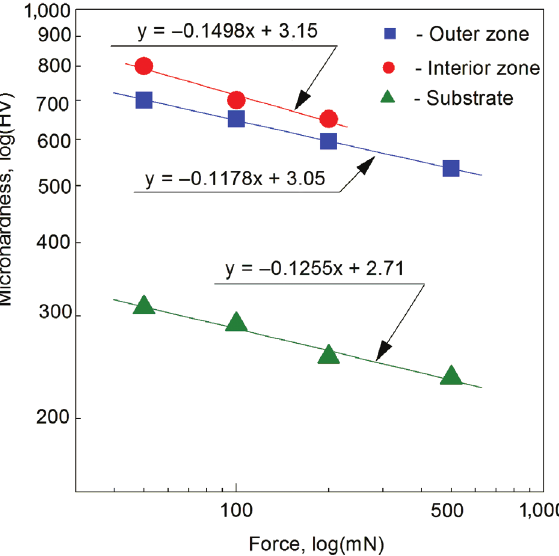
Figure 10: Influence of the load on the microhardness value for the substrate material and aluminide coating zones made on Inconel 625 superalloy (parameters of CVD process: T ¼ 1,050 °C, t ¼ 8 h, p ¼ 150 hPa).